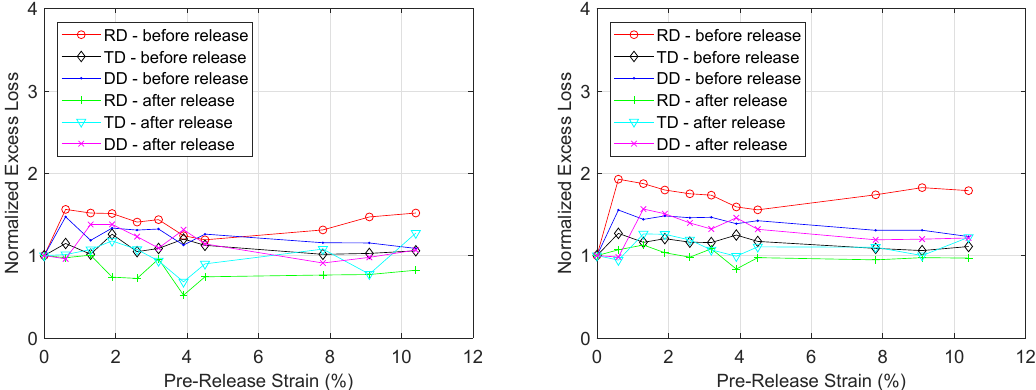
Figure 11. Evolution of excess losses under increasing levels of strain at 100 Hz and B p = 0.6 T ( left ) and at 400 Hz and B p = 0.6 T ( right ). The results are normalized with respect to the excess losses before plastic